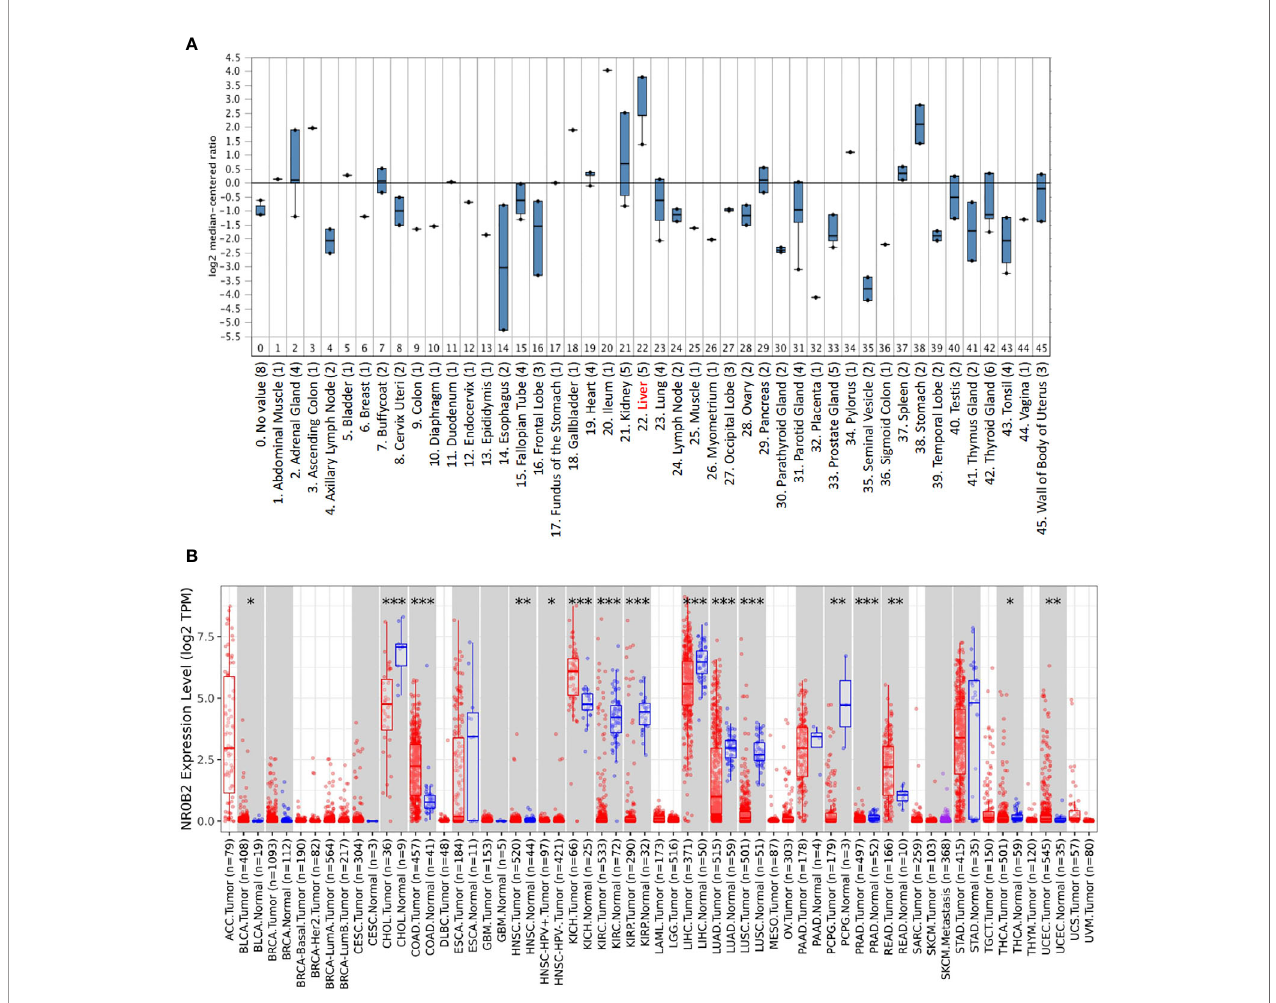
FIGURE 1 | NR0B2 expression pro fi les in benign and malignant tissues. (A) NR0B2 gene expression pro fi les in human tissues were queried from the Shyamsundar cDNA microarray dataset (20) in the Oncomine database. Box plot was generated based on the log 2 median-centered ratio in each organ/tissue type. (B) The differential pro fi les of NR0B2 gene expression between malignant and adjacent benign tissues were queried from the TCGA tumor database on the Tumor Immune Estimation Resource (TIMER) platform (16, 17). Data are displayed using box plots. The statistical signi fi cance of differential expression was analyzed using the Wilcoxon test. *p < 0.05, **p < 0.01, ***p <